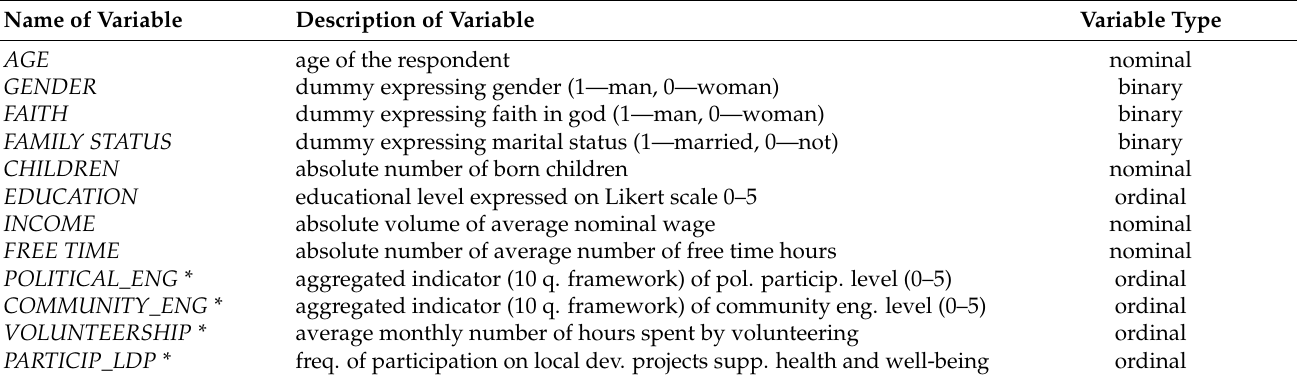
Table 1. Description of variables used to test outlined